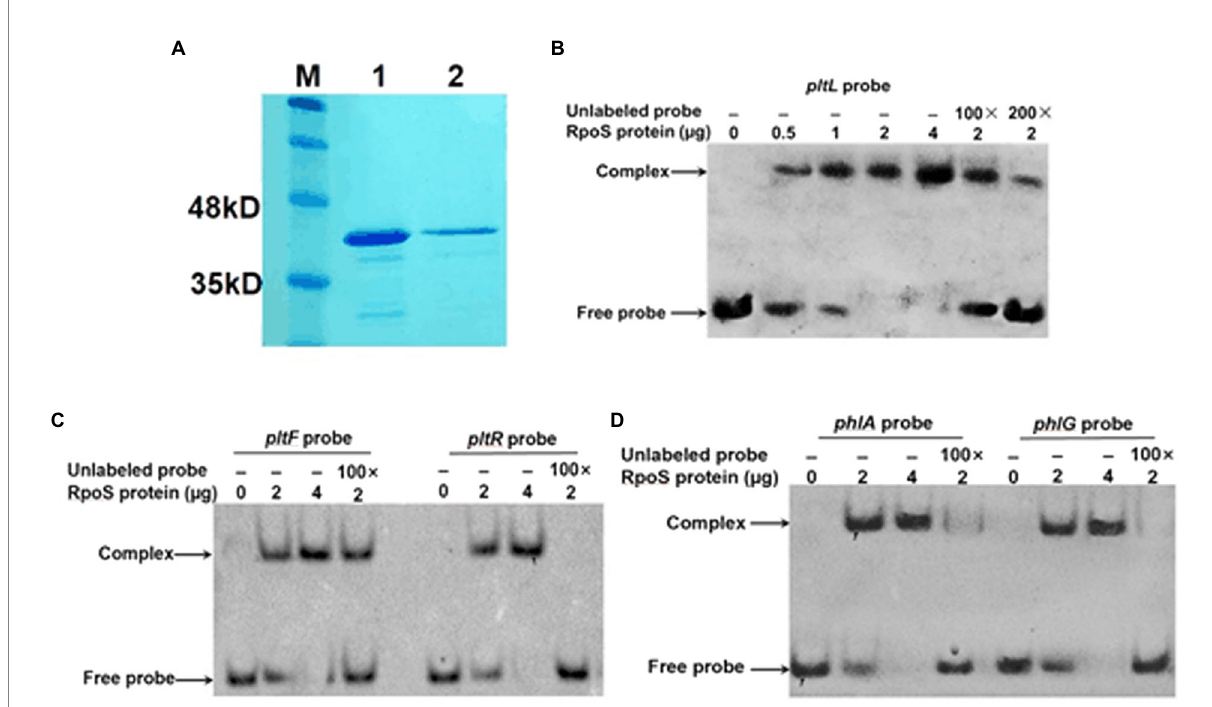
FIGURE 6 Direct interaction of RpoS with the promoter regions of antibiotic biosynthesis clusters. (A) Purification of the RpoS protein. M: Protein standard marker; 1–2 the pure RpoS (protein eluted with 200 mM and 250 mM imidazole). (B–D) An electrophoresis mobility shift assay was used to evaluate the interaction between RpoS and labeled DNA probes. The amount of RpoS used in this experiment is shown above each gel. The concentration of labeled probe was 1 μ M. An excess of unlabeled probe was used in the competitive